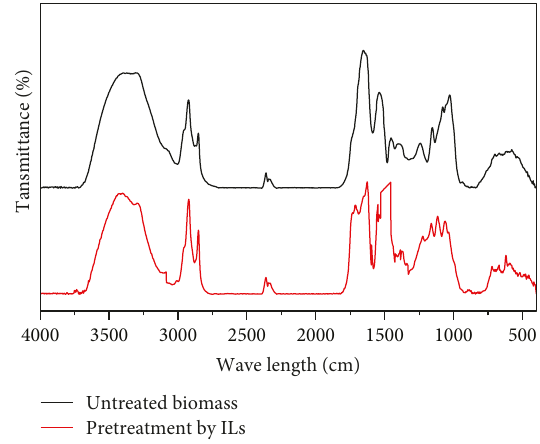
Figure 3: FTIR of microalgae before and after treatment with [BMIM]MeSO 4